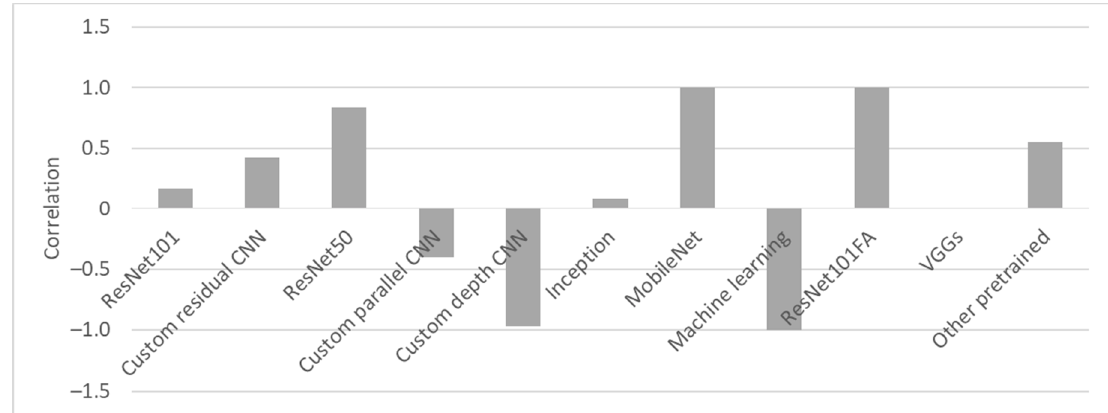
Figure 8. Correlation of the backbone performance with training dataset size.